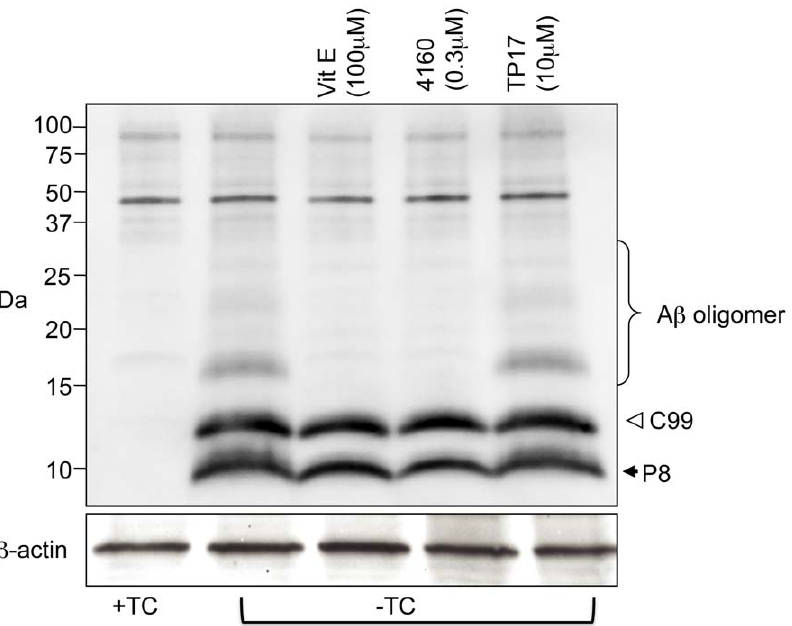
Figure 3. SLF HO-4160 greatly diminishes the intracellular population of oligomeric A b Shown are Western blots of extracts from the MC65 human neuroblastoma cell line that conditionally expresses C99, a 99-residue carboxyl terminal fragment of APP in the absence of tetracycline ( 2 TC). C99 is subsequently cleaved by cellular c -secretase to generate A b . TP17, an inactive tricyclic pyrone, serves as a negative control [31], while vitamin E (Vit E), a potent antioxidant that was shown to also block A b O formation in MC65 cells [30], serves as a positive control. p8 is an unresolved band that could be an A b homodimer, or a heterodimer of A b and APP D 31 [31], a caspase cleavage product involving residues just downstream from the A b origin on APP. The presence of this band does not correlate with MC65 cell death [31]. Blotting was carried out using the A b antibody 6E10 (upper panel) and the loading control (lower panel) was probed using an antibody directed against b -actin. The blot shown is representative of 3 replicates.